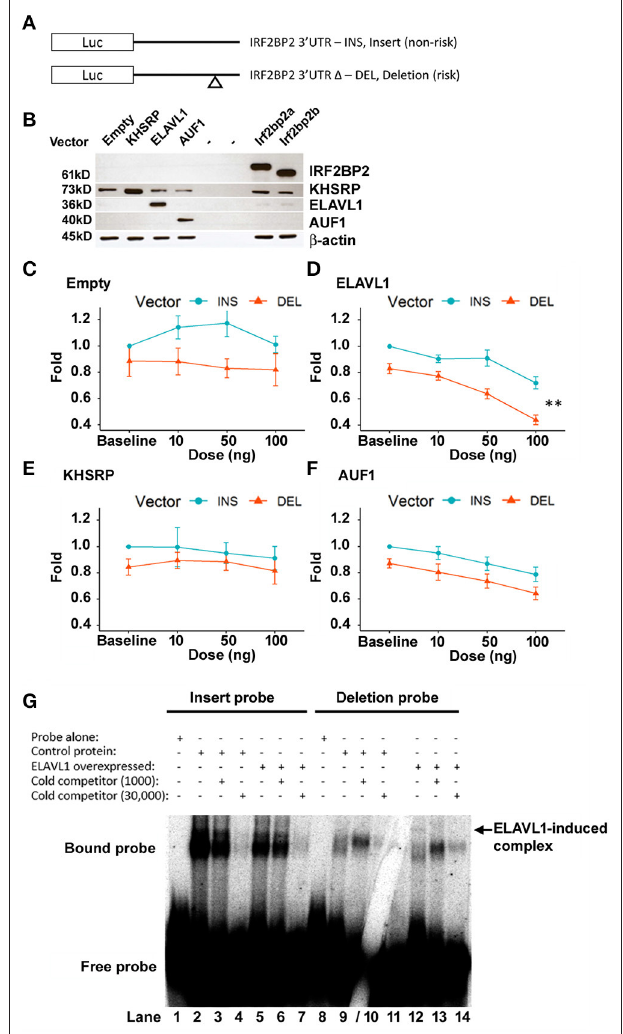
FIGURE 3 | The deletion variant confers ELAVL1-dependent suppression of luciferase reporter activity. (A) CMV-driven luciferase reporter plasmids bearing the 3 ′ UTR sequence of IRF2BP2 and differing only in the presence of the non-risk allele (pCMV-i-3 ′ UTR-IRF2BP2, INS, non-risk) or the risk allele (pCMV- 1 -3 ′ UTR-IRF2BP2, DEL, risk) of rs3045215 were transfected into human HEK293 cells with either empty expression vector ( N = 5), KHSRP ( N = 5), AUF1 ( N = 7), or ELAVL1 (HuR) ( N = 7). (B) HEK293 whole cell lysates show similar levels of over-expressed RBP after transfection with each expression plasmid. Plasmids expressing the IRF2BP2a and IRF2BP2b splicing isoforms were used as transfection controls. β -actin served as a loading control. Activity of luciferase reporters was compared when co-transfected with various doses of expression plasmids: (C) empty expression plasmid, (D) ELAVL1, (E) KHSRP, and (F) AUF1. The luciferase reporter activity was expressed as a normalized fold relative to